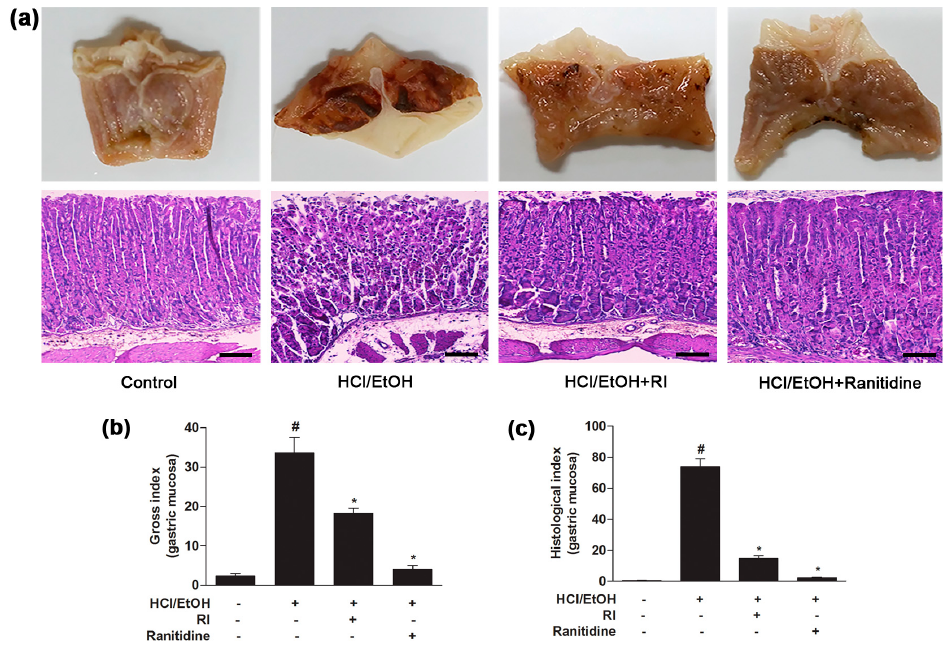
Figure 3. Protective role of RI on HCl/EtOH-induced gastric damage in mice: ( a ) gross lesion (upper panel) and histological lesion (lower panel) (scale bar. 200 µm); ( b ) gross lesion index; and ( c ) histological index. # p < 0.05 when compared with the control and * p < 0.05 when compared with HCl/EtOH. Data are expressed as mean ± SEM.